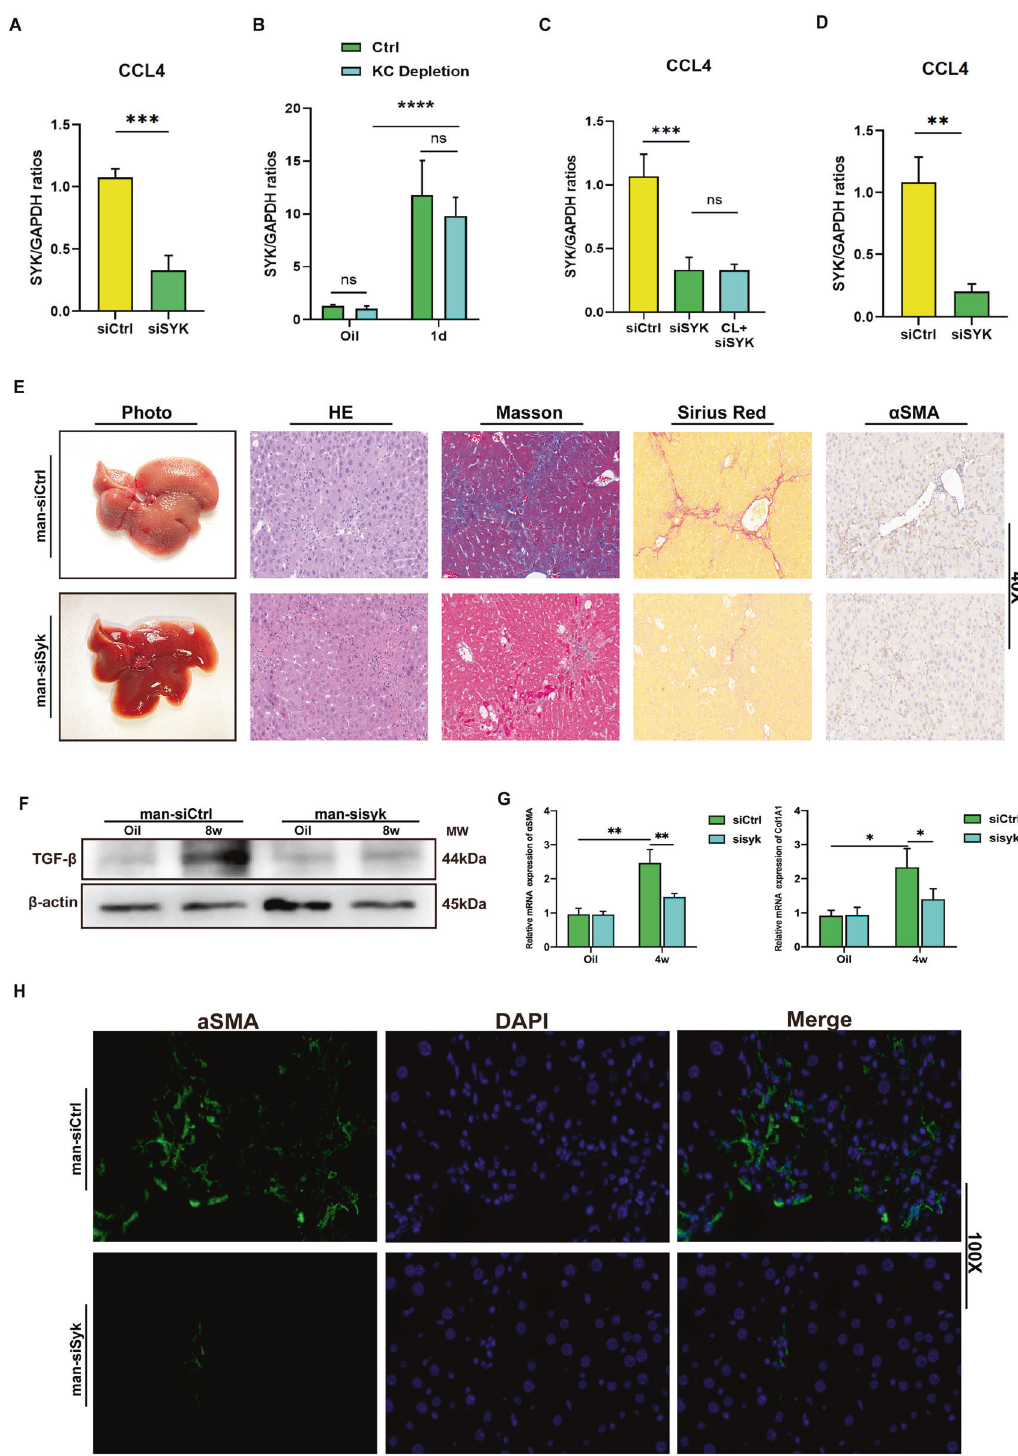
Fig. 2 Blocking MoMFs SYK helped relieve mice liver fi brosis. A C57 mice were treated with a mixture of siSYK or siCtrl and mannose- conjugated JetPEI-polyplus (mannose-conjugated, JetPEI-polyplus) 4 h before the injection of CCL4 through the tail vein to blockade the transcription of SYK in liver macrophages. The mRNA level of liver SYK in siSYK or siCtrl groups was detected by qPCR 24 h after the injection of CCL4 (*** P < 0.001); B Depleted Kupffer cells with CL before CCL4 injection, then detected SYK mRNA levels 24 h later (**** P < 0.0001); C The level of SYK mRNA of siCtrl, siSYK and CL + siSYK groups after CCL4 injection (*** P < 0.001); D And, 8 weeks after injection of CCL4, detected the expression of SYK by qPCR in siCtrl and siSYK groups (** P < 0.01); E Fibrotic liver was detected by photos, HE, masson, Sirius red staining and immunohistochemistry of α -SMA; F Determined the expression of TGF- β protein in the liver by Western blot; G The expression of α -SMA and Col1A1 in the liver by qPCR; H Immuno fl uorescence of α -SMA to detect the expression in liver tissue (magni fi cation 100x).